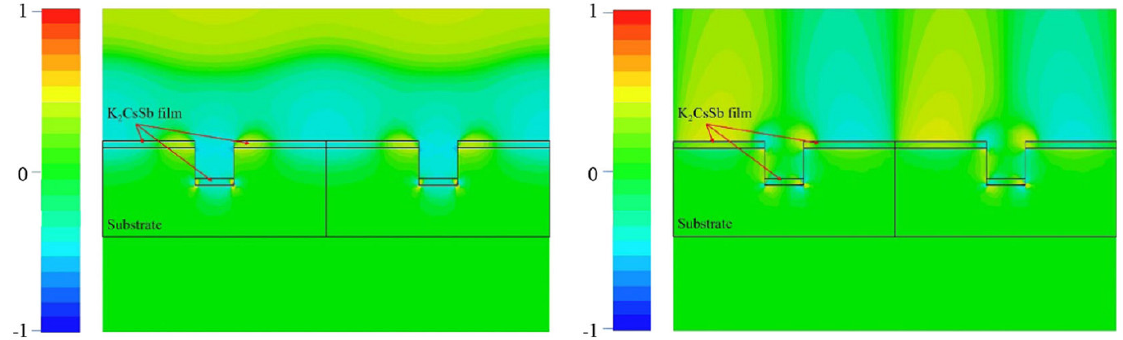
Figure 13. Electric field distribution of PNF over cross section. Left and right images show electric field distributions of X and Y components of PNF, respectively [73].